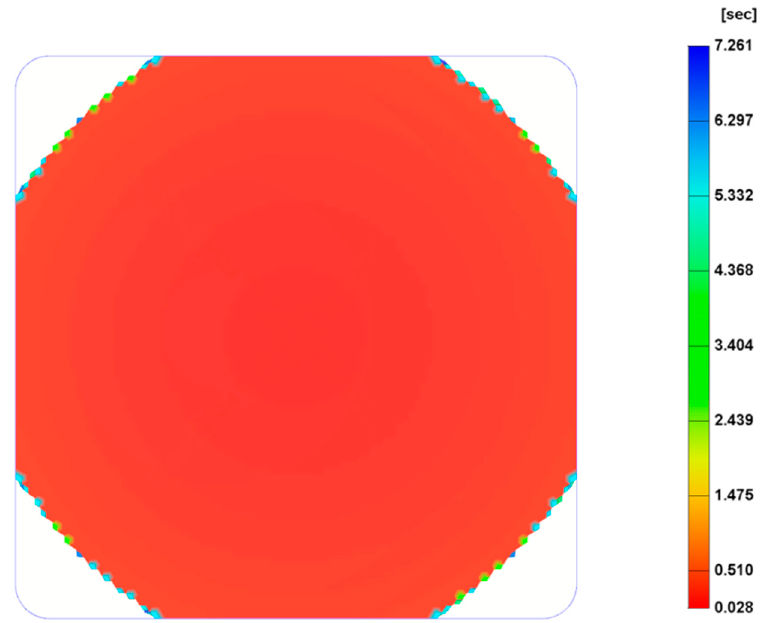
Figure 10. Melt front time when the gas dosage amount is 0.1%.